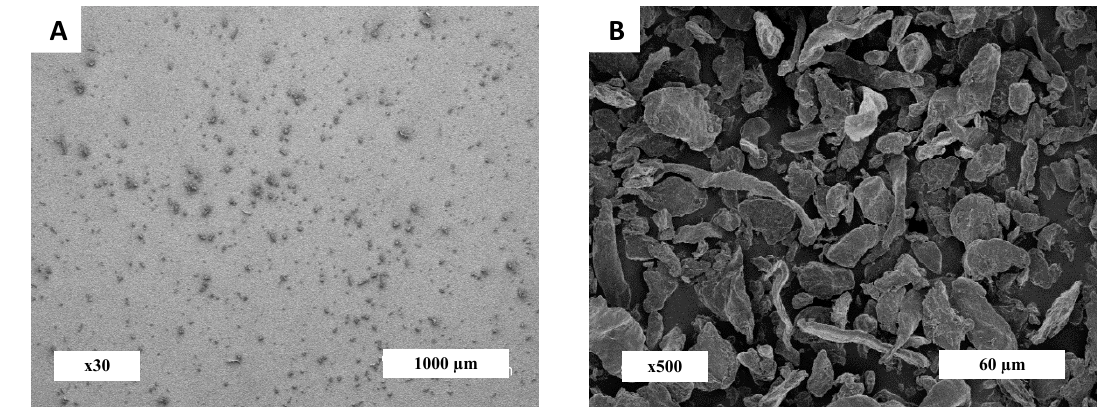
Figure 1. Scanning electron microscopy (SEM) images of cellulose particles of magnitude ( A ) ×30 and ( B ) ×500.